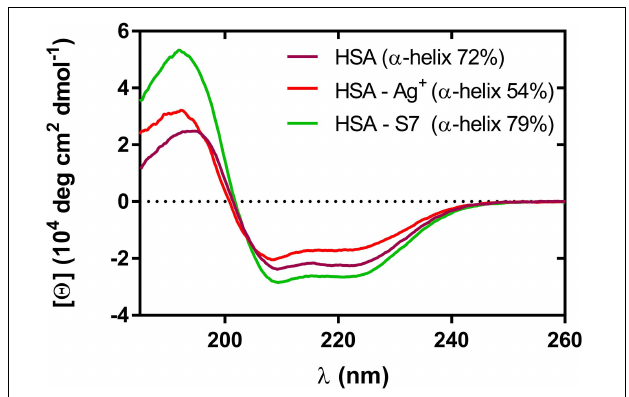
FIGURE 4 | Circular dichroism spectra of HSA in the presence of AgNO 3 and S7 sample. C(HSA) = 1.5 µ M, C(Ag + ) = 240 µ M, C(S7) = 2 ppm. The fractional contents of HSA α -helices calculated from CD spectra by the Dichroweb platform (CDSSTR with dataset SP175) are described in the